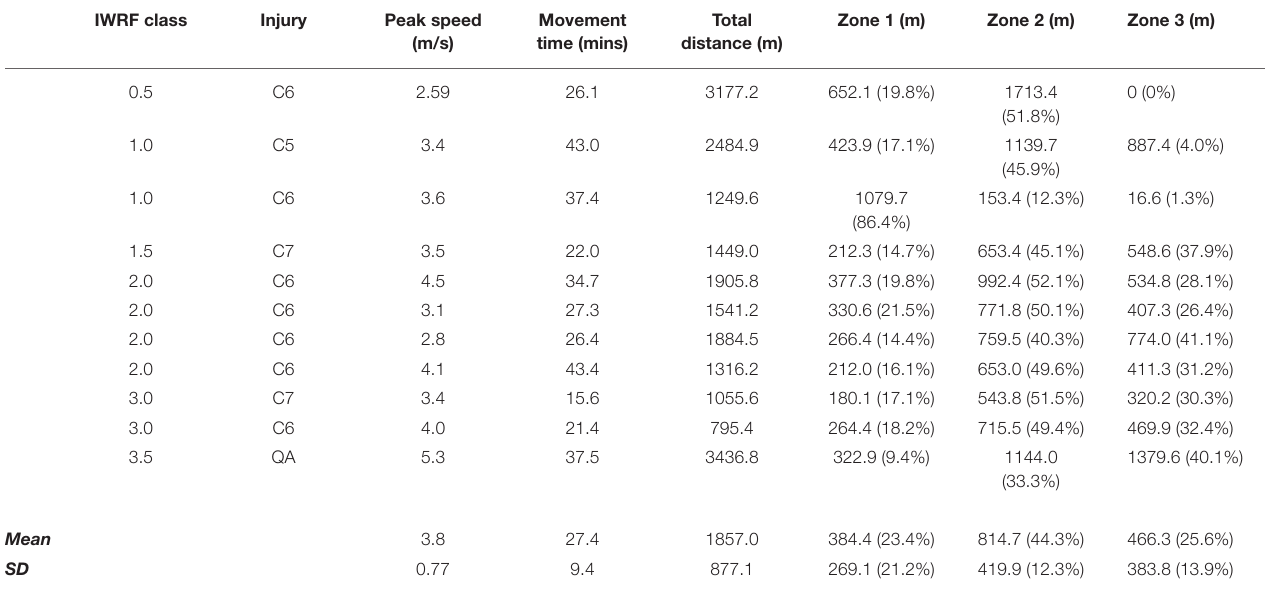
TABLE 2 | WC kinematics throughout the WC